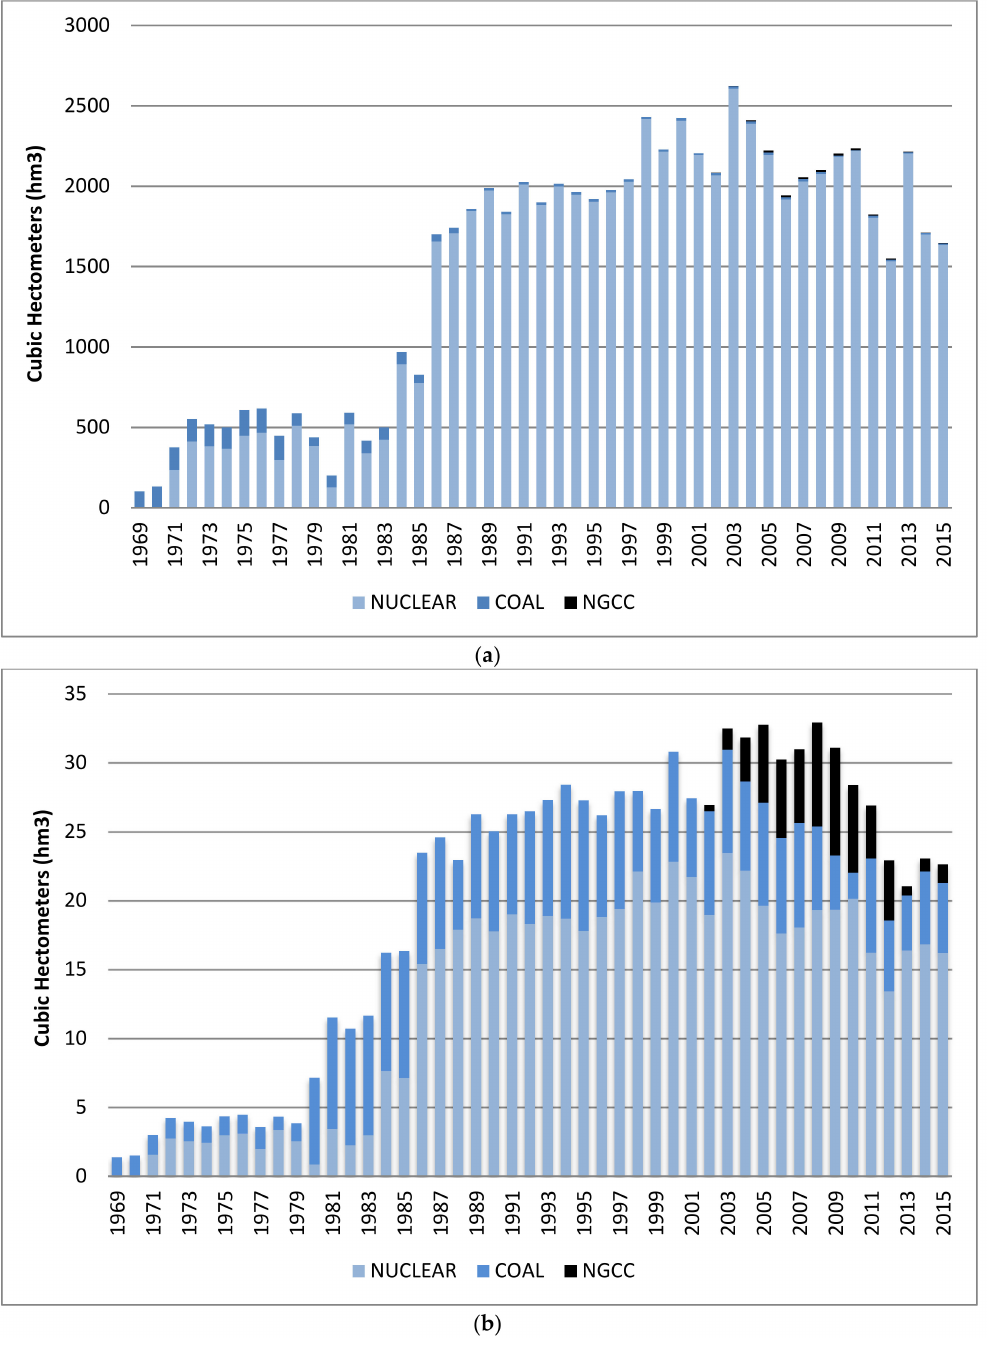
Figure 4. ( a ) Evolution of total water withdrawals by type of technology in the Ebro River basin, 1969–2015. Source: own design (see ’Data File S1’ in Supplementary Materials). ( b ) Evolution of total water consumption by type of technology in the Ebro River basin,1969–2015. Source: own design (see ’Data File S1’ in Supplementary